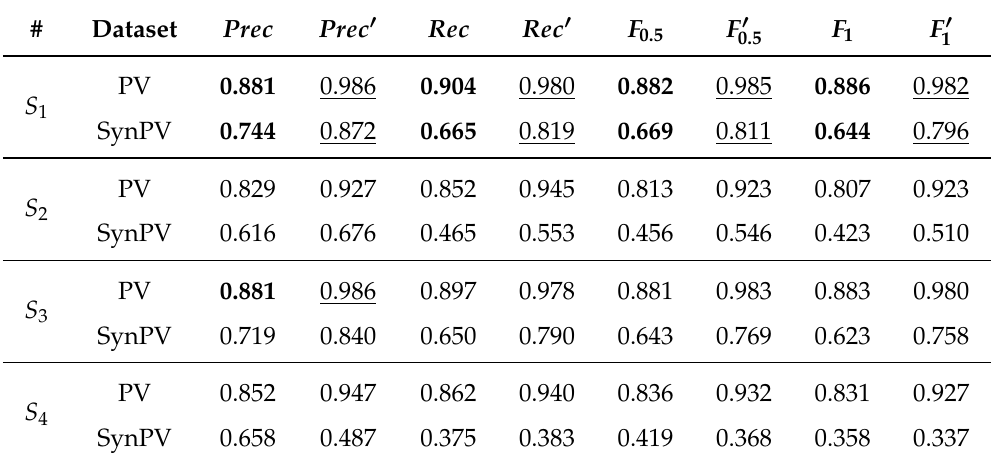
Table 3. Resulting test performance of the model trained with the parameters in Table 2 over the original dataset PlantVillage (PV) and the synthetic one (SynPV), simulating grass on the back- ground. Results are shown with the original proposal ( Prec , Rec , F 0.5 , and F 1 ) and the new one using the array of cameras ( Prec (cid:48) , Rec (cid:48) , F (cid:48) , and F (cid:48) 0.5 1